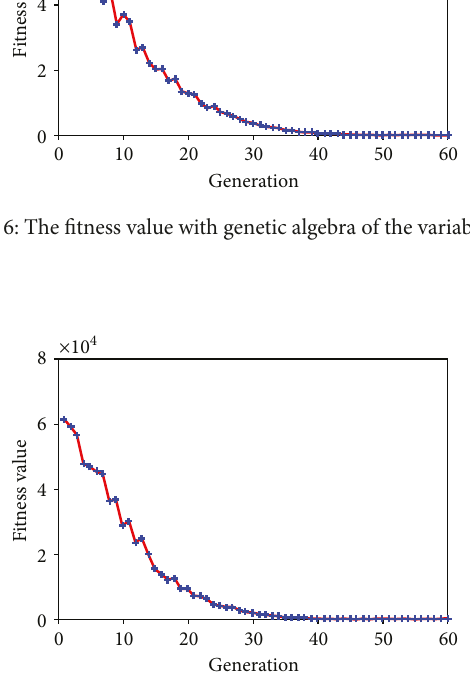
Figure 7: The fi tness value with the genetic algebra of the invariable span missile.